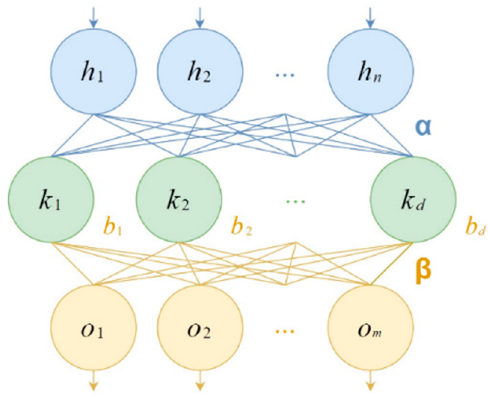
Figure 4. The structure of an extreme learning